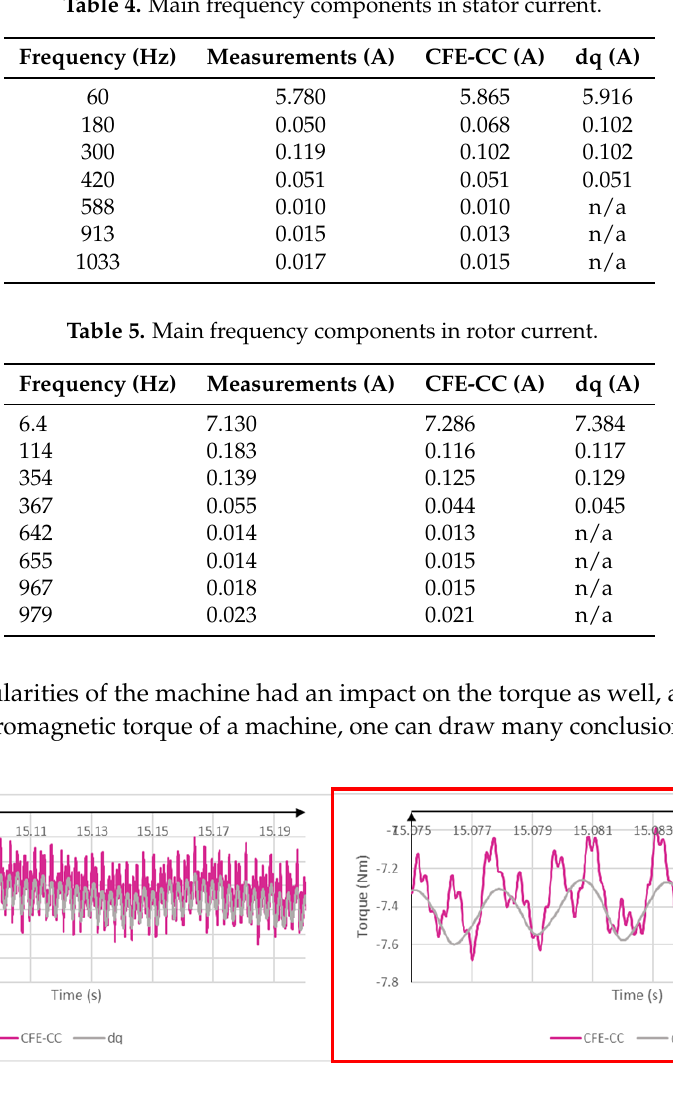
Figure 9. Electromagnetic torque during load operation, enlarged on right